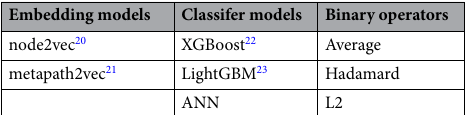
Table 3. Summary of models and operators to be selected.